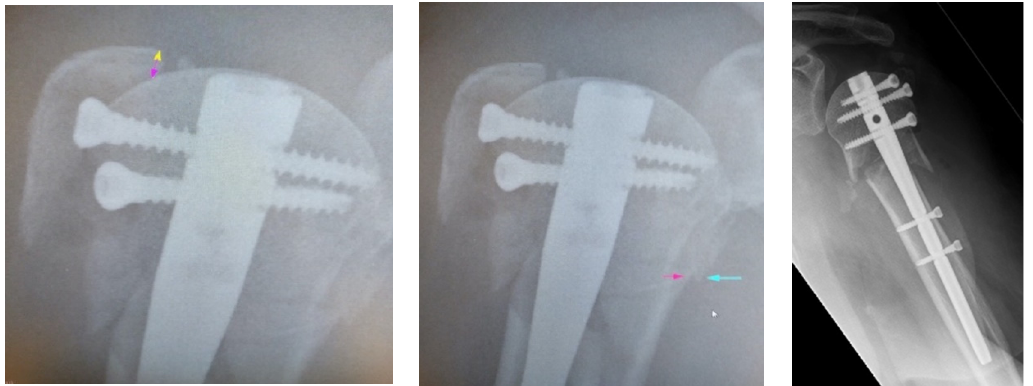
Figure 3. Left: Cranialization of GTB, Middle: Missing integrity of the medial hinge. Right: Head- Shaft-Alignment 196°.